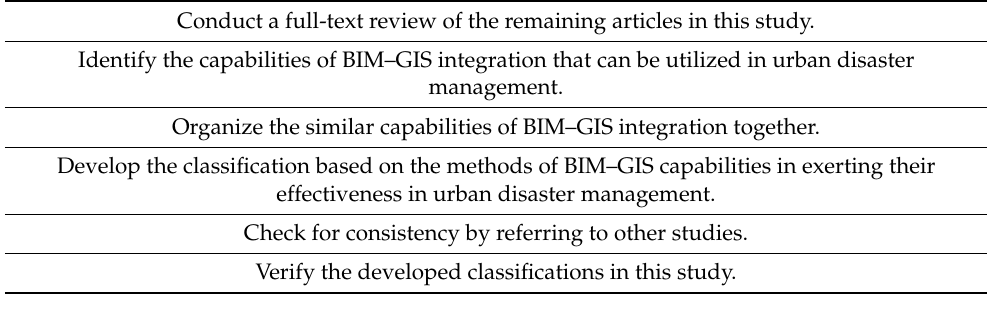
Table 3. The Detailed Process of Classification Development.